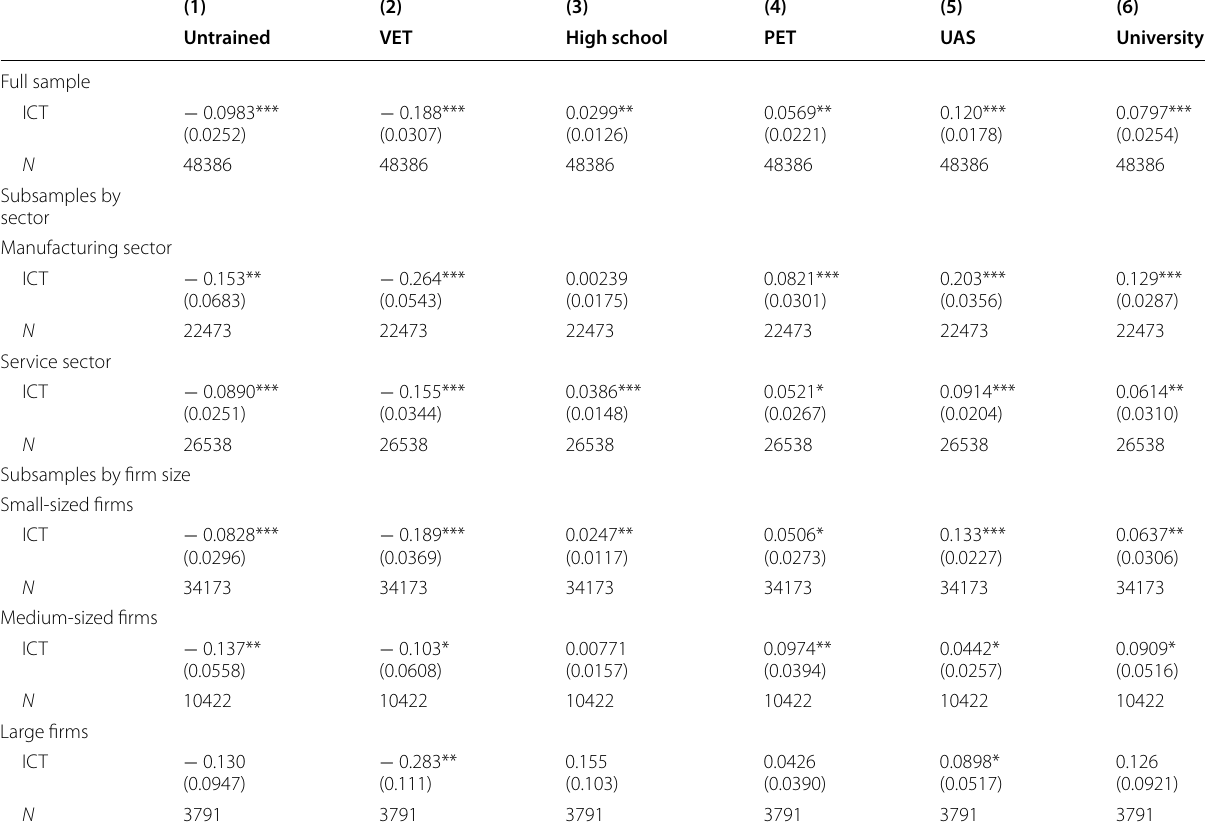
Table 4 Pseudo-panel FE estimations: